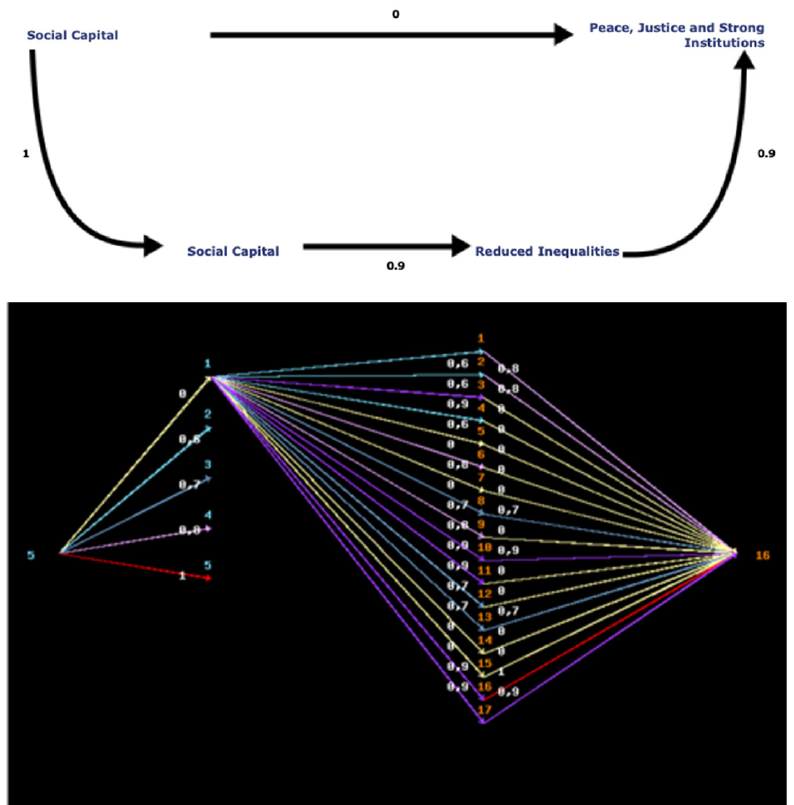
Figure 14. Relation between Social Capital (H5) and Peace, Justice, and Strong Institutions (SDG16).